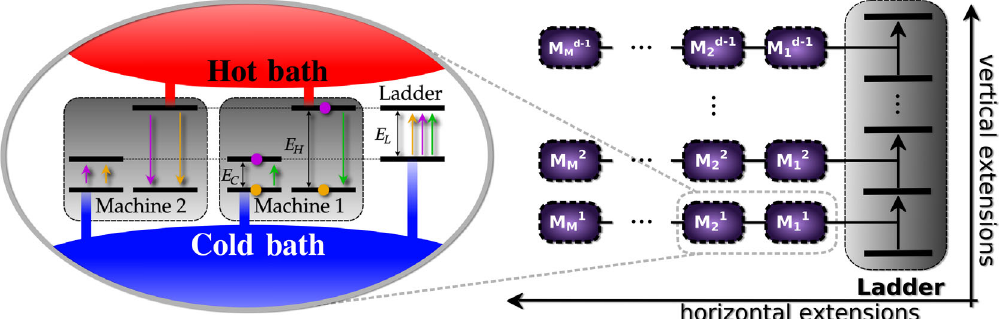
FIG. 3. On the right-hand side, the notion of “ horizontal ” and “ vertical ” extension is schematically illustrated. The ladder dimension d determines the number of vertical extensions ( “ rows ” ). Each pair of neighboring energy levels of the ladder couples to M copies of the two-qubit machine, where M determines the number of horizontal extensions ( “ columns ” ). On the left-hand side, the energy-level structure of a horizontally extended machine for a two-machine clockwork coupling to a two-level ladder ( d ¼ 2 ) is illustrated. This case is a special case of the generalized clockwork shown on the right-hand side. The different energy-conserving transitions induced by H are indicated by the differently colored arrows and dots, where the dots represent a conditioning of the transitions of machine 2 either on the ground state (orange) or on the exited state (purple) of machine 1. The reverse transitions are not depicted here for the sake of